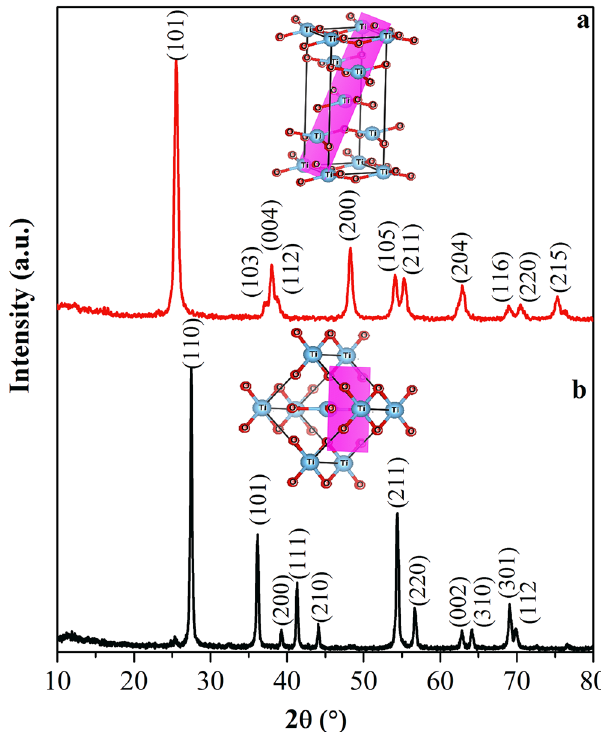
Figure 1. XRD patterns of ( a ) anatase, and ( b ) rutile TiO 2 . The unit cells are drawn in inset with the lattice parameters obtained from Rietveld refinement. The major reflecting plane of each polymorph is